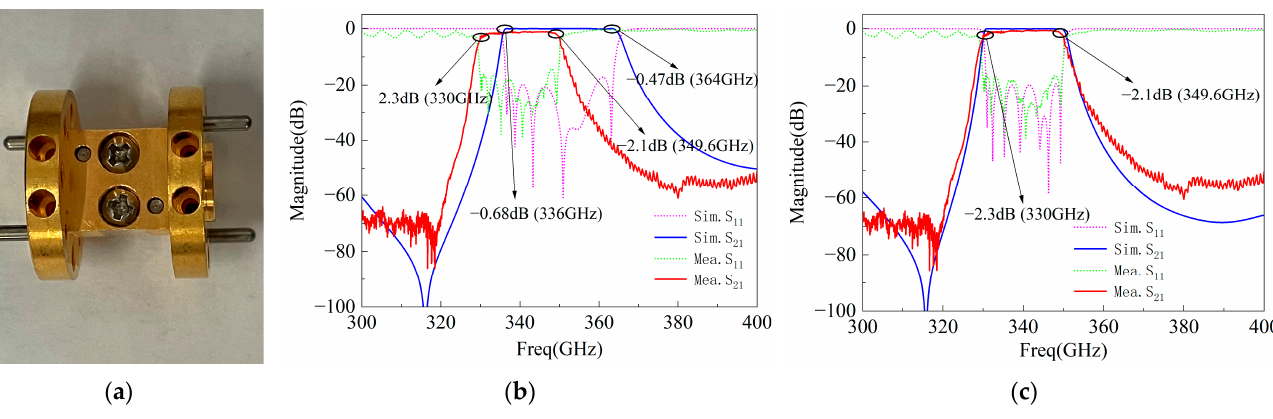
Figure 8. The filter structure and S 21 changes with asymmetry. ( a ) Filter structure of horizontal shift; ( b ) filter structure of vertical shift; ( c ) S 21 changes with m 2 ; ( d ) S 21 changes with m 4 .